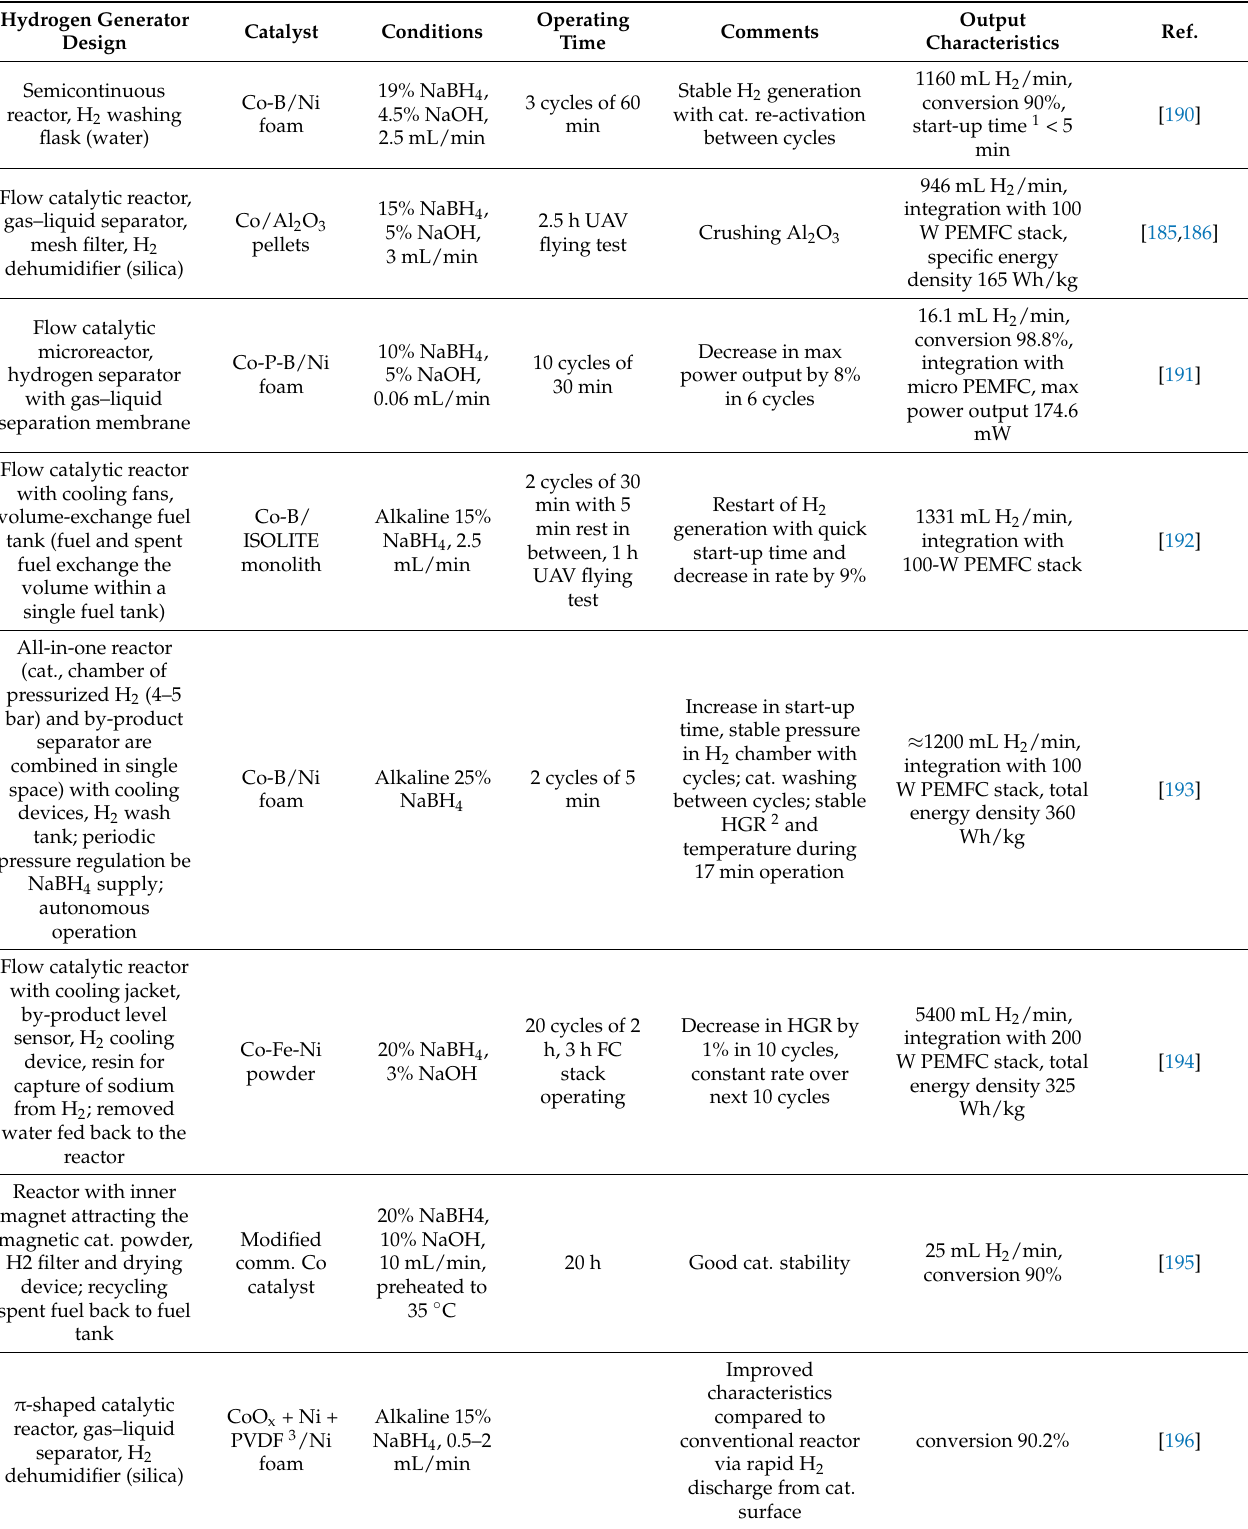
Table 4. The reported hydrogen generators with Co-containing